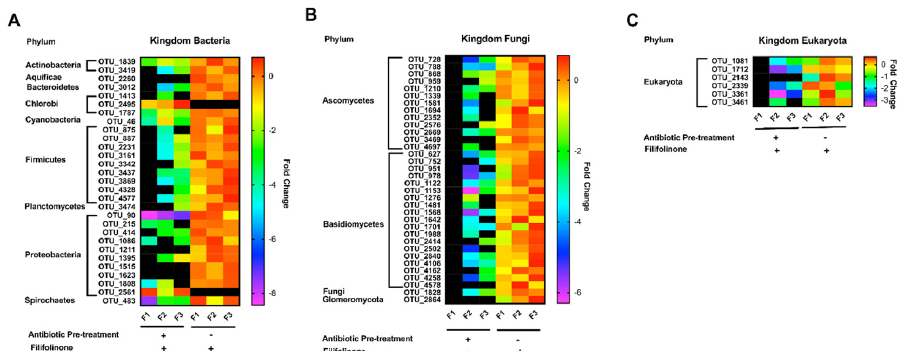
Figure 10. E ff ect of antibiotics on OTUs that respond to filifolinone. The figure shows the groups of OTUs that respond to filifolinone (102), the abundance of which is a ff ected significantly ( p < 0.05) by the pre-administration of bacitracin and neomycin (69 OTUs). The figure shows ( A ) OTUs belonging to the Kingdom Bacteria; ( B ) OTUs belonging to the Kingdom Fungi; and ( C ) OTUs belonging to the Kingdom Eukaryote. The abundance of each OTU was normalized by the highest mean, either from samples from fish treated with filifolinone or samples from fish pre-treated with antibiotics before filifolinone was administered. The relative abundance is shown on a color scale. Statistical